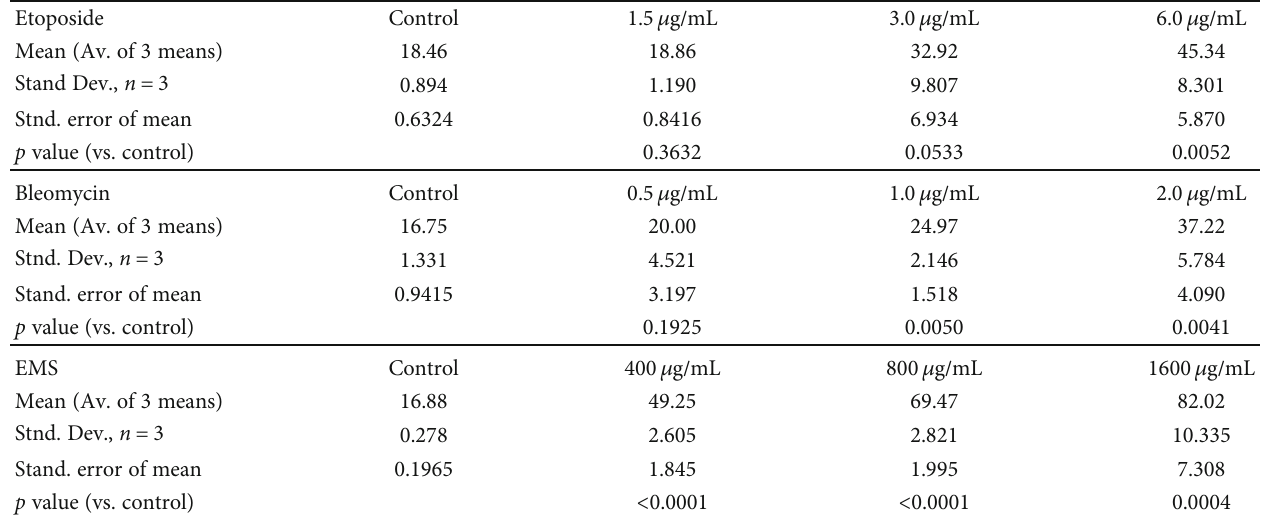
Table 1: Statistical analysis of multiple comet assays (% DNA in tail).